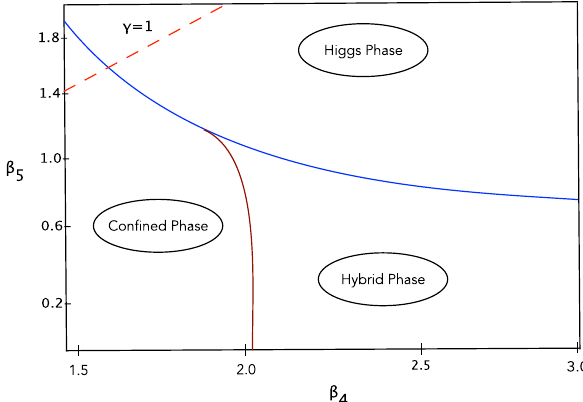
Fig. 1 The phase diagram of the anisotropic orbifold lattice [6,7]. It exhibits three distinct phases, the confined, the Higgs and the Hybrid phase, separated by either bulk-driven (blue) or by boundary-driven (red)first-orderphasetransitions.Thedashedlinecorrespondsto γ =